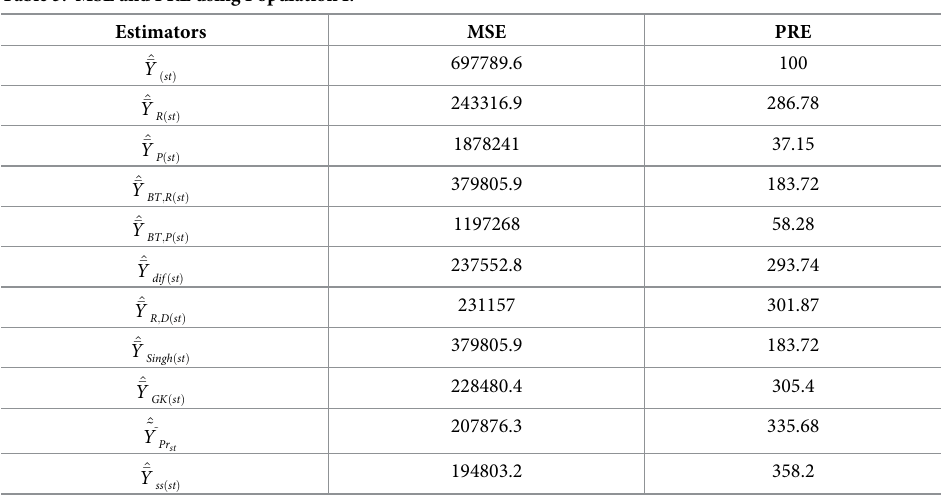
Table 3. MSE and PRE using Population I.